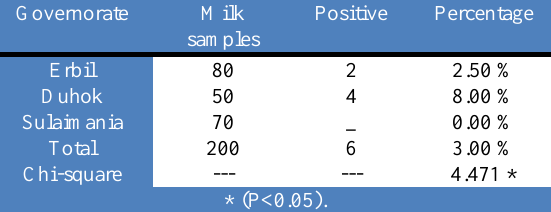
Table, 6: Shows the number and percentage of M. capricolum on Real time PCR in milk samples.